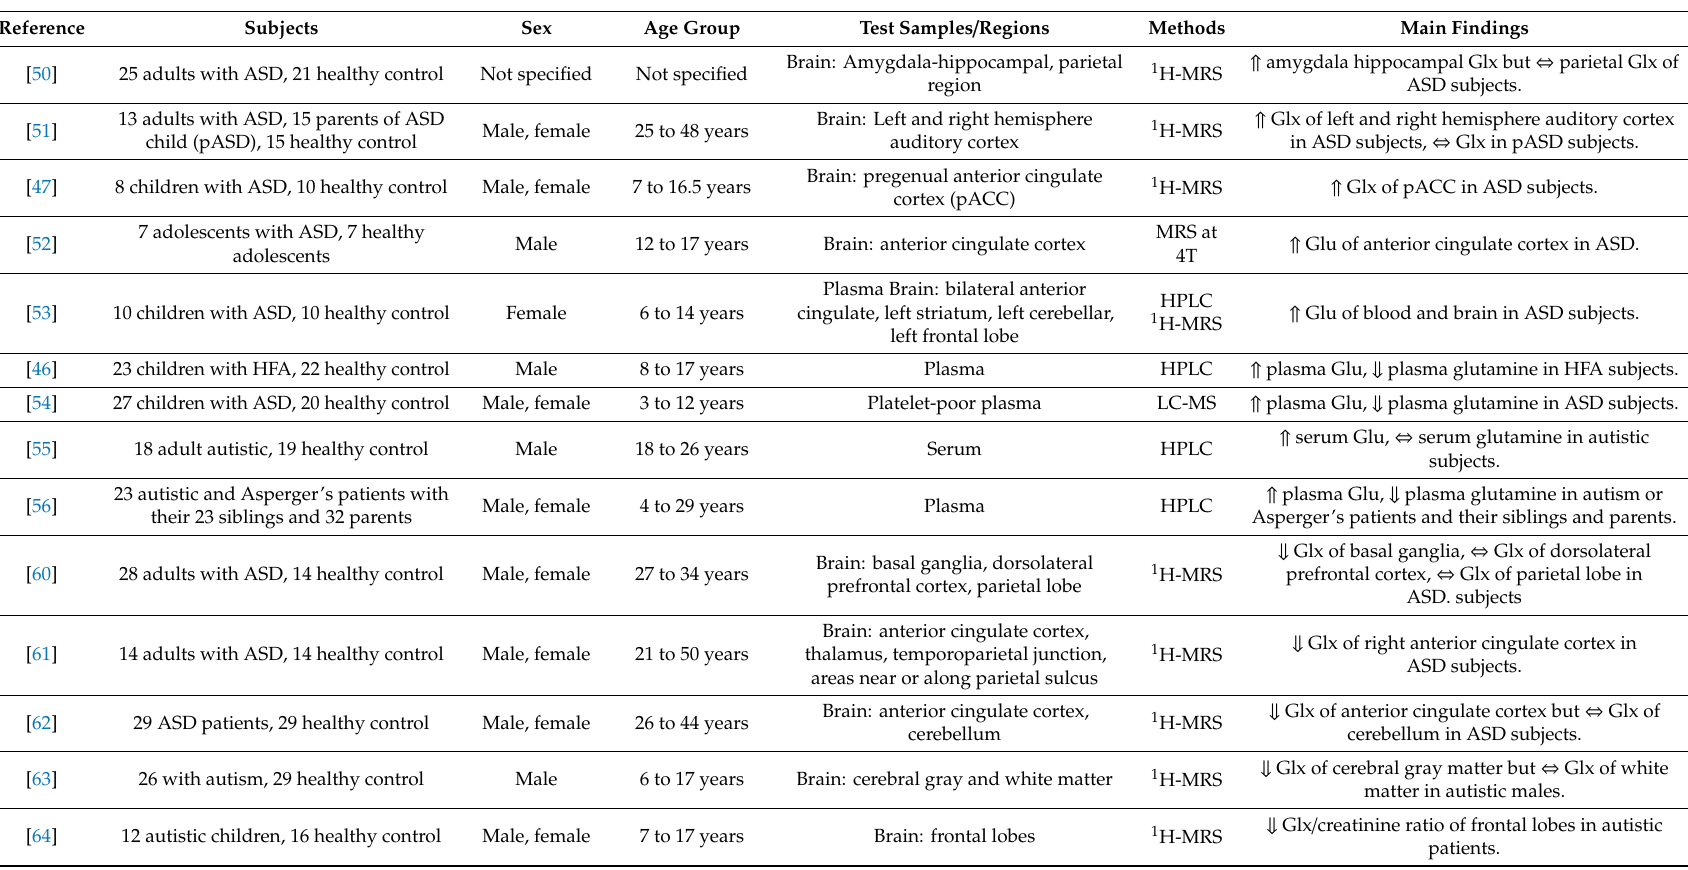
Table 3. Summary for previous evidence on dysfunction of glutamatergic neurotransmission in